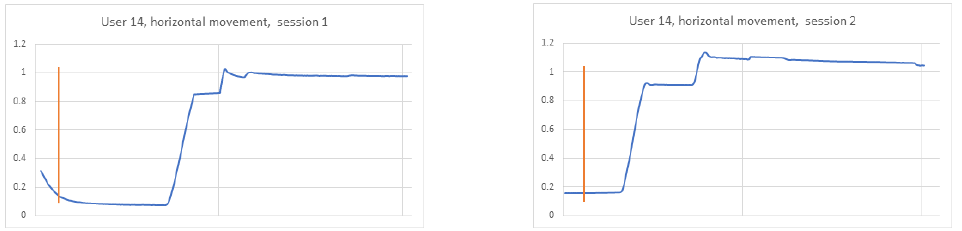
Figure 10. Horizontal signal–user 14 session 1 on the left , session 2 on the right